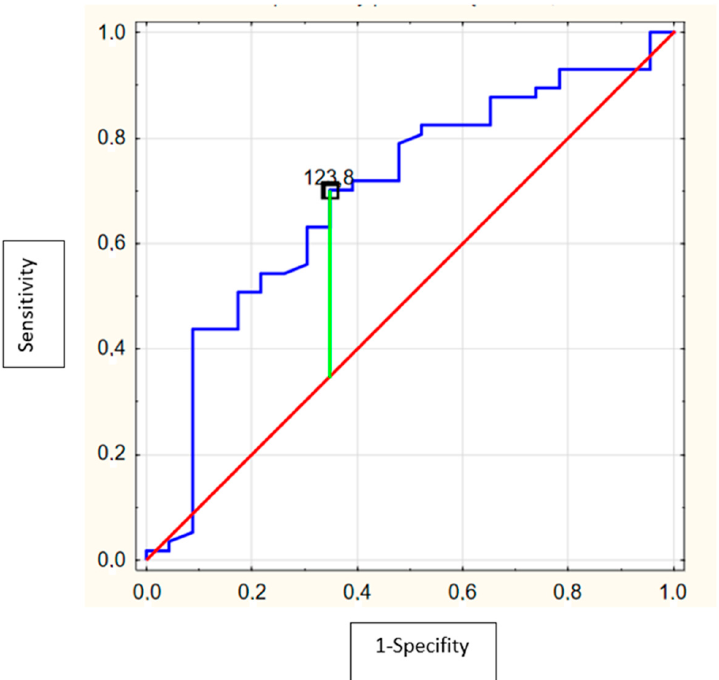
Figure 4. Receiver operating characteristics (ROC) curve of the ability of TIMP-1 to differentiate the